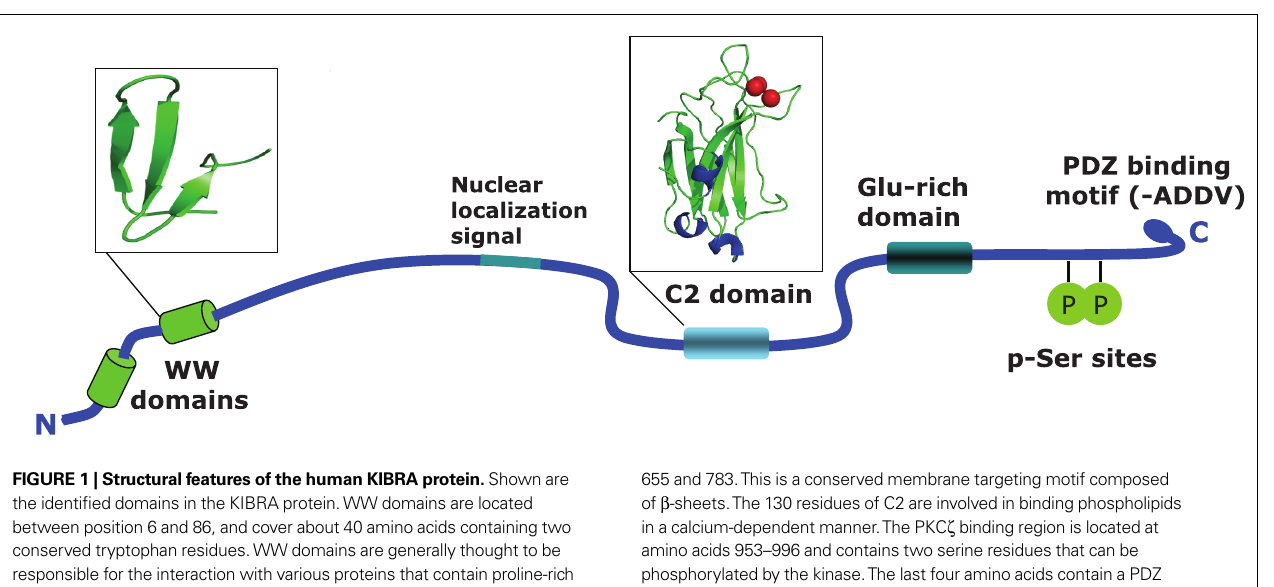
655 and 783. This is a conserved membrane targeting motif composed of β -sheets. The 130 residues of C2 are involved in binding phospholipids in a calcium-dependent manner. The PKC ζ binding region is located at amino acids 953–996 and contains two serine residues that can